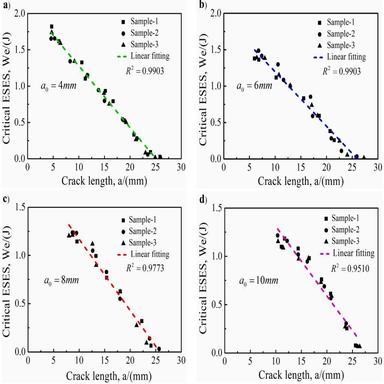
The fitting lines between the critical elastic strain energy storage We and various crack lengths a of the U-notches with different initial lengths a0 during the crack propagation. (a) a0 = 4 mm; (b) a0 = 6 mm; (c) a0 = 8 mm; (d) a0 = 10 mm.